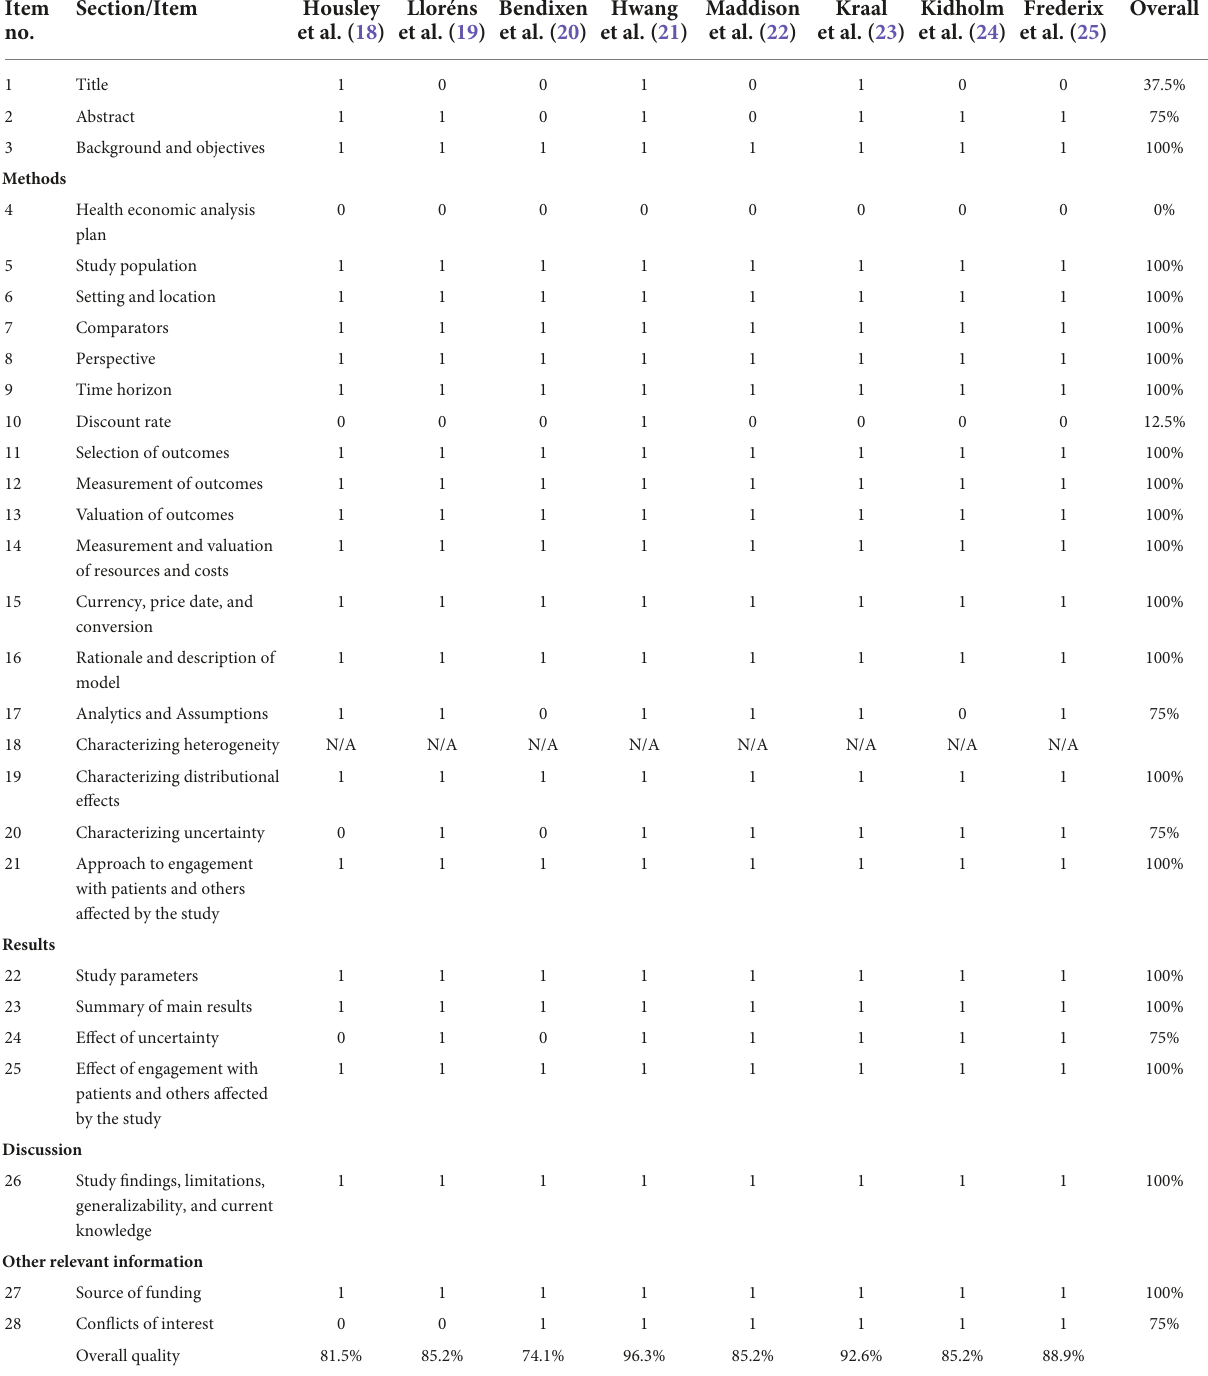
TABLE 3 Quality of the included studies using CHEERS 2022 checklist. Item